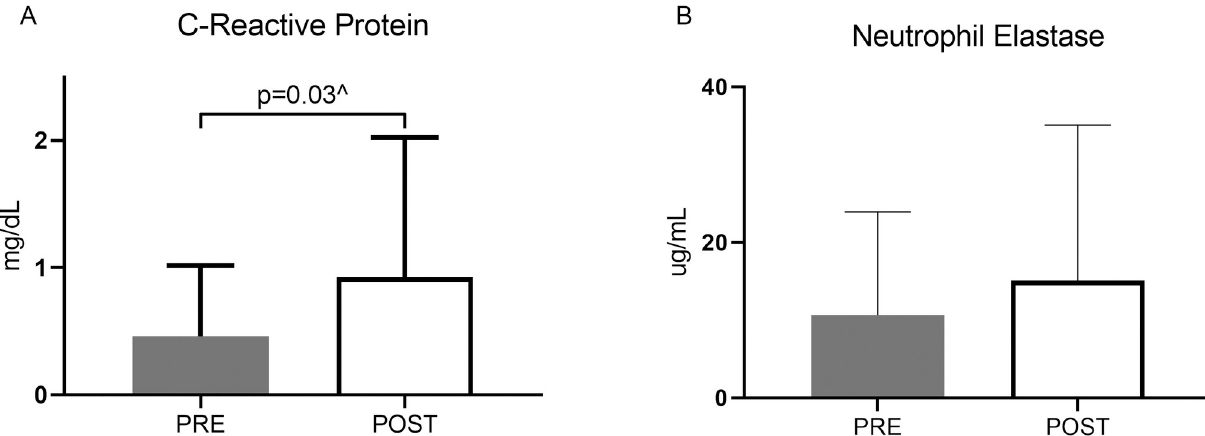
Fig 3. Effect of inhaled AZLI on markers of inflammation pre and post treatment. (A) C-reactive protein (CRP) measured from blood samples. ^p = 0.03 for Wilcoxon matched-pairs signed rank test. (B) Sputum neutrophil elastase. Comparisons were based on paired t-tests, from log-transformed data. Solid columns represent pre-treatment; open columns represent post-treatment. Bars represent mean values and error bars represent SDs on the same scale as means.